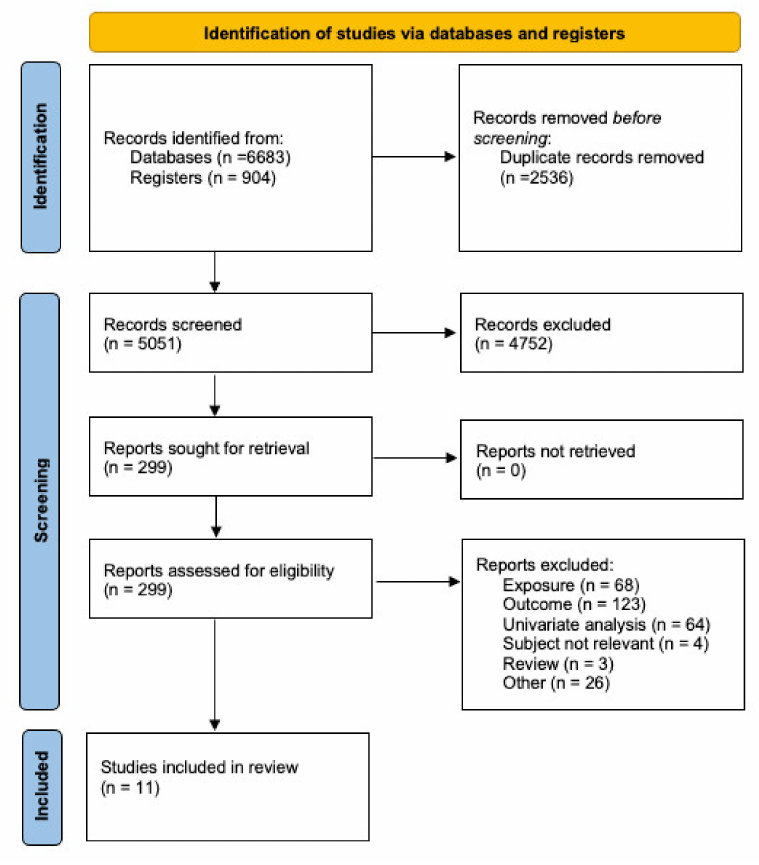
Figure 1. PRISMA